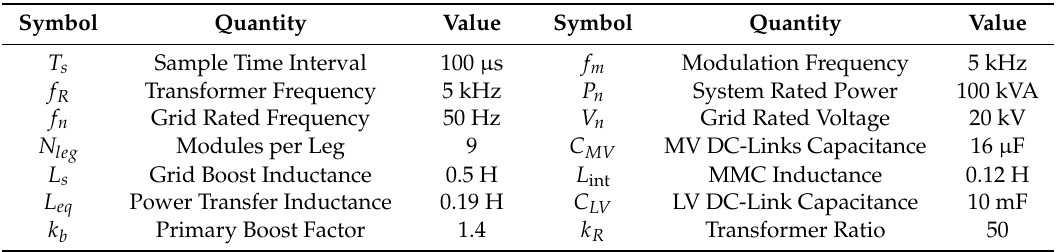
Table 1. Simulation parameters.